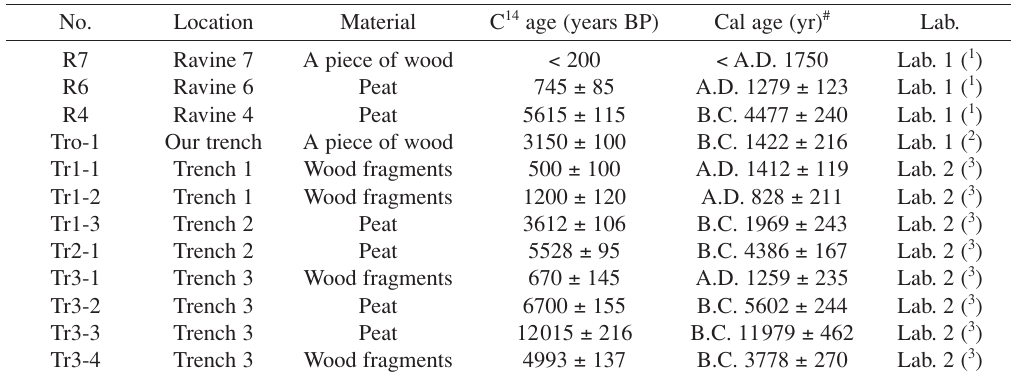
Table II. Radiocarbon